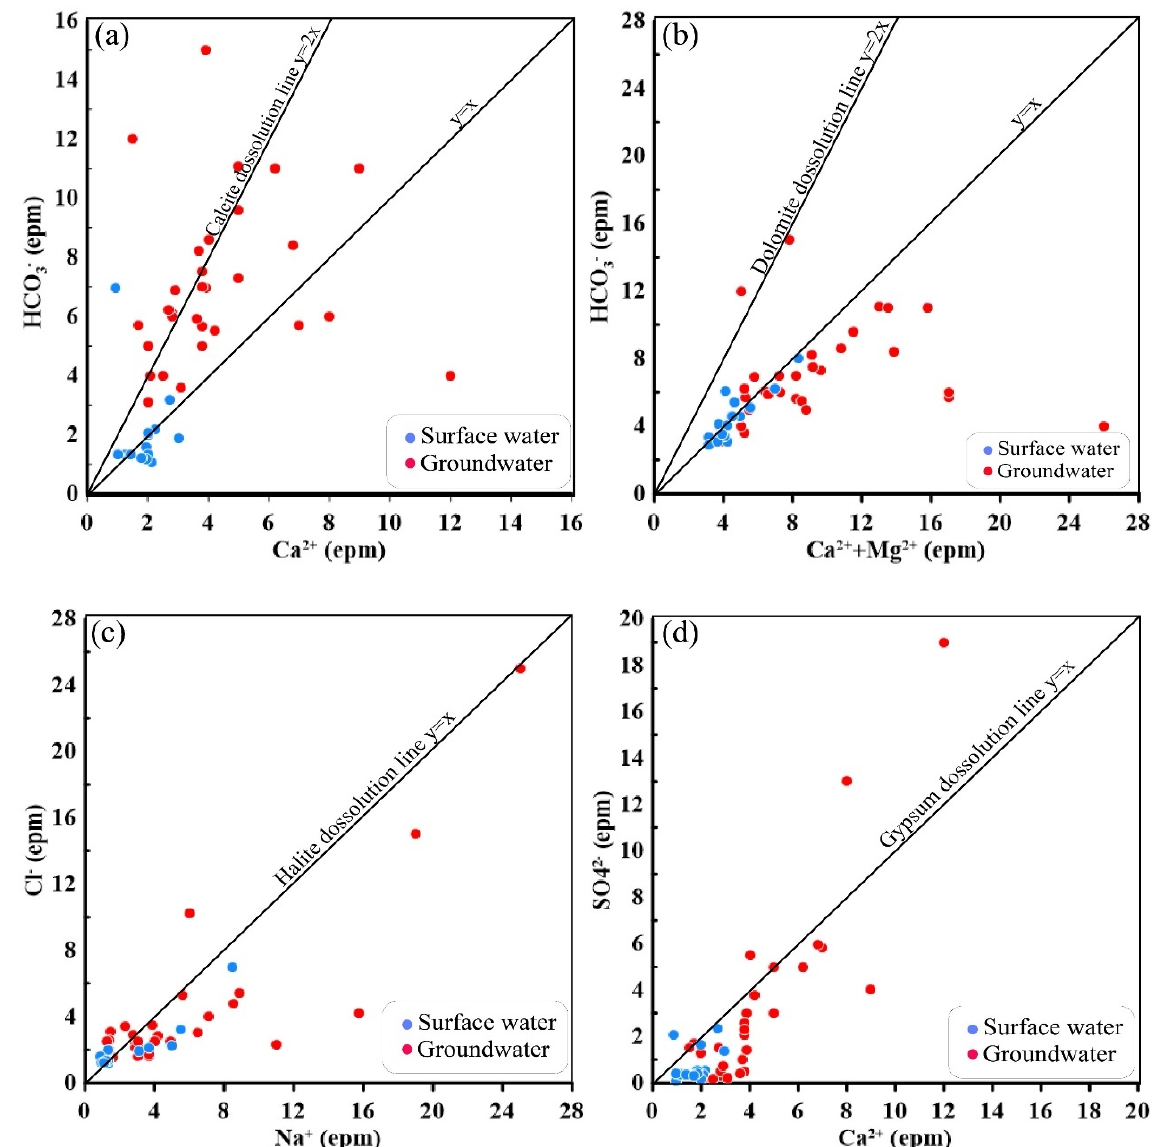
Figure 5. The relationships between the major ions show the dissolution process in the studied water samples ( a – d